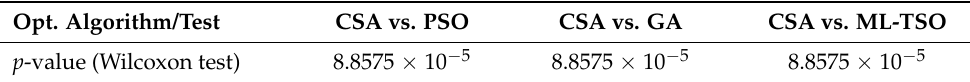
Table 4. Wilcoxon’s rank-sum test for the 57-bus test network.